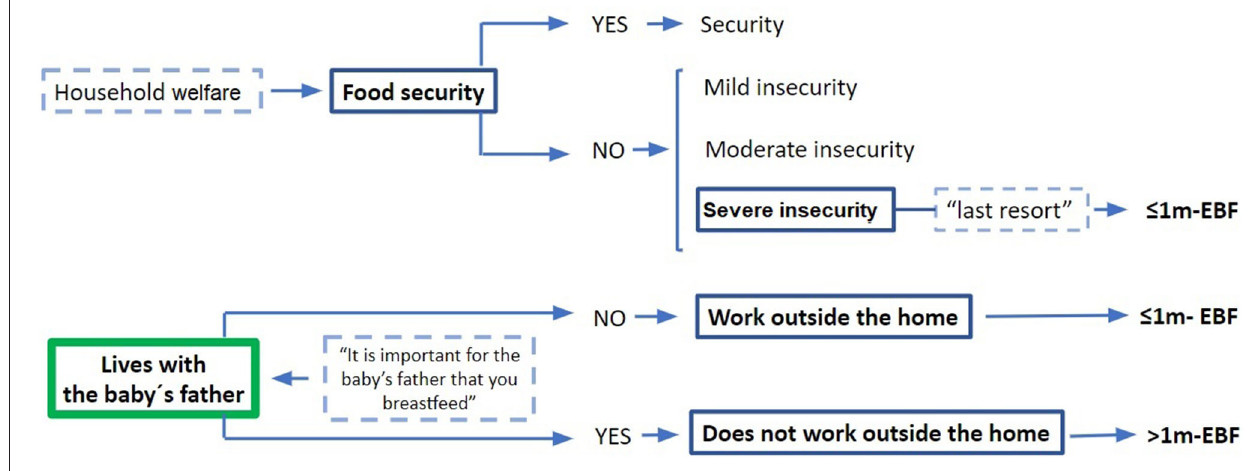
position the infant on the breast. Neither prenatal care were statistically different between the ≤ 1 m-EBF and > 1 m-EBF